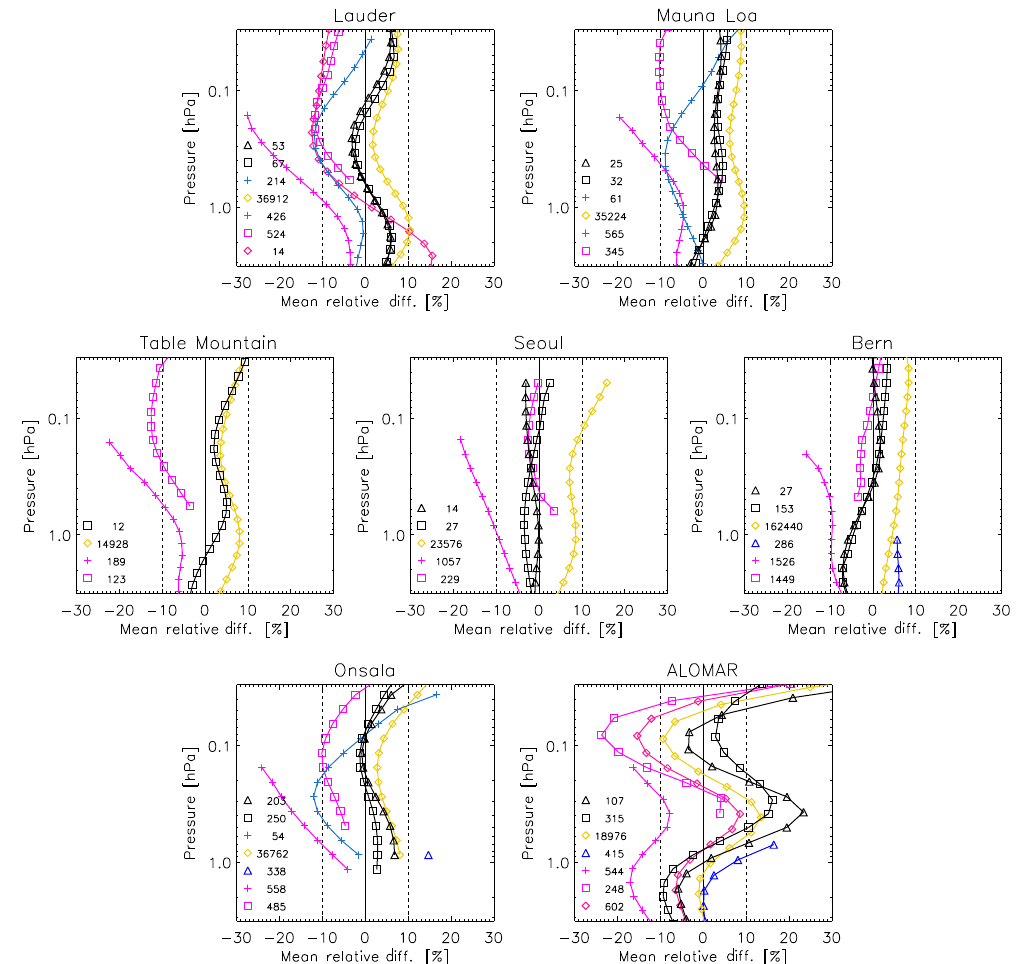
Figure 3. The average difference between coincident non-MIPAS satellite measurements and ground-based measurements at seven sites shown from south to north. Results are shown from 3 to 0.3hPa. The difference shown is convolved satellite minus GBMW using the satellite symbols given in Fig. 1. The numbers on the left of each panel indicate the number of